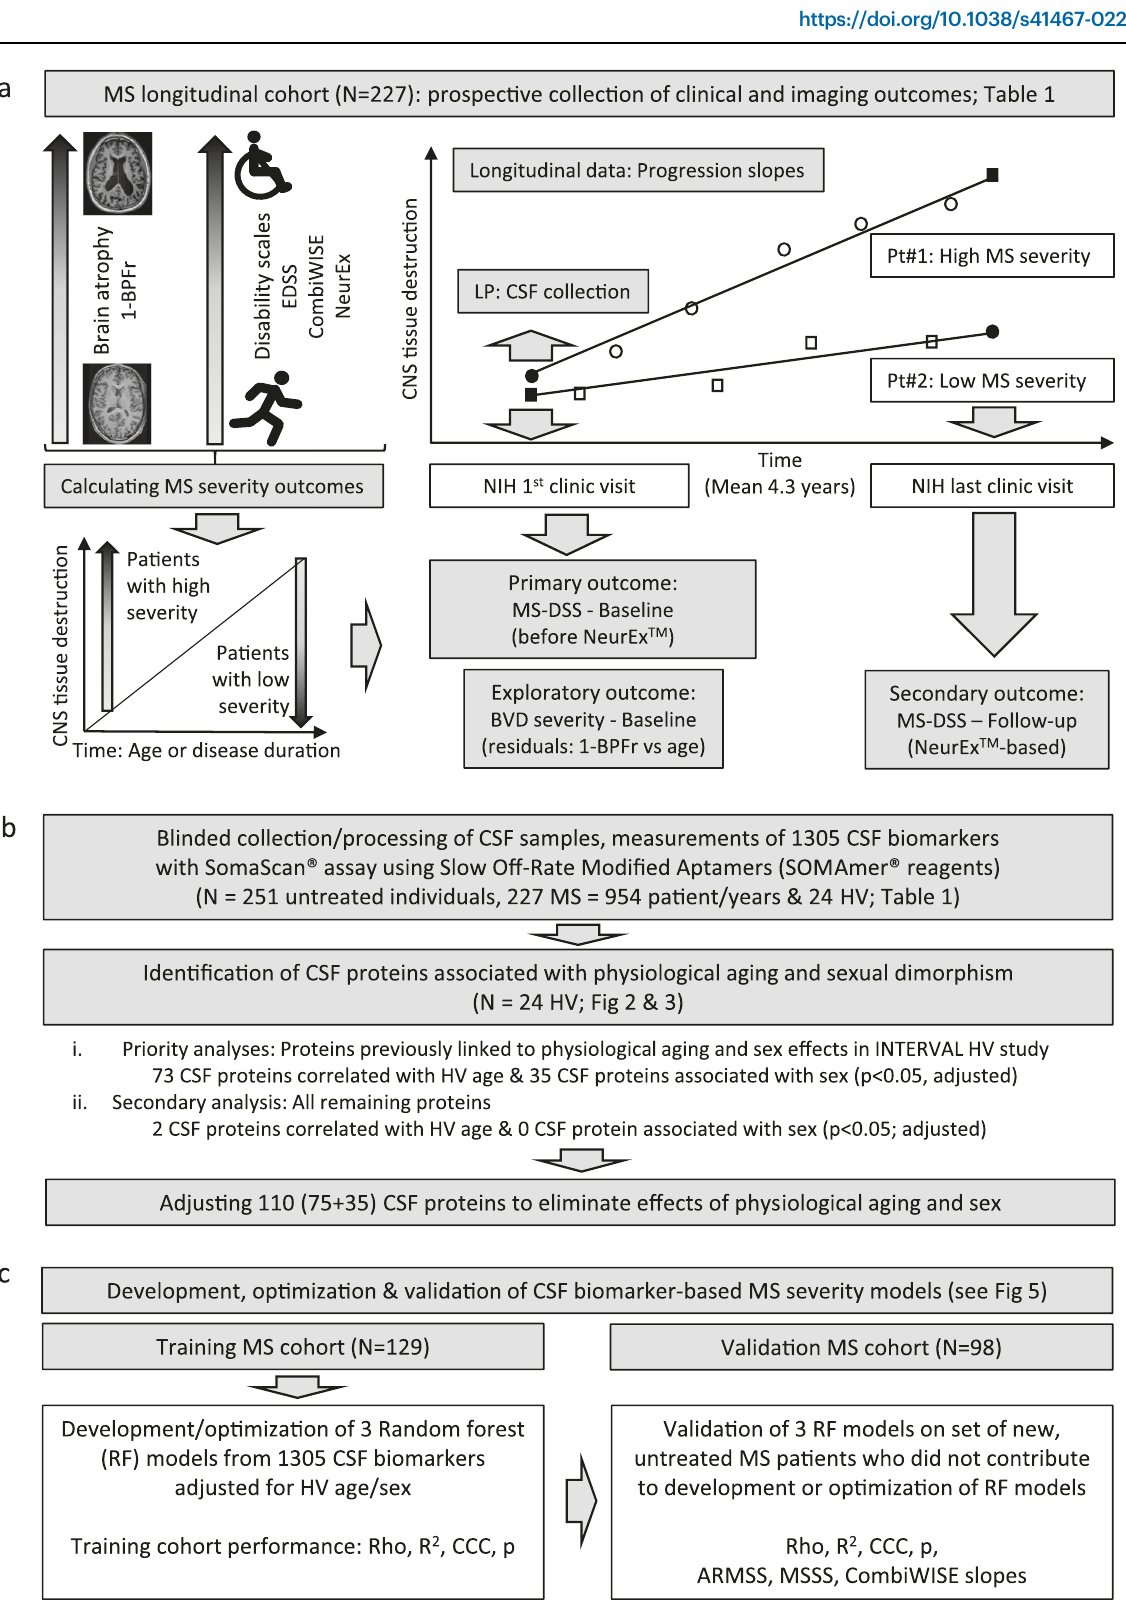
was applied to training cohort ( N =129) data, resulting in three models of MS severity. Models ’ performance was assessed by Spearman Rho, R 2 , Concordance CorrelationCoef fi cient(CCC),and p -value( p )oftheSpearmancorrelationbetween observed and model-predicted values. The validity of the three models was then evaluated in an independent cohort ( N =98) by measuring the above-mentioned characteristics of the observed vs predicted outcomes. MS-DSS Multiple Sclerosis Disease Severity Scale, BVD brain volume de fi cit.